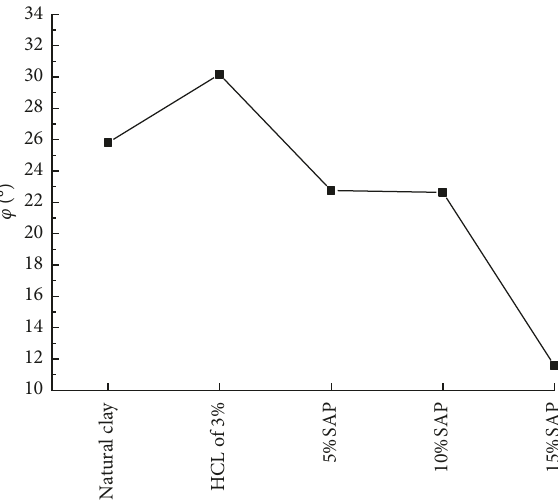
17: Variation in internal friction angle of SAP-cured acid- contaminated